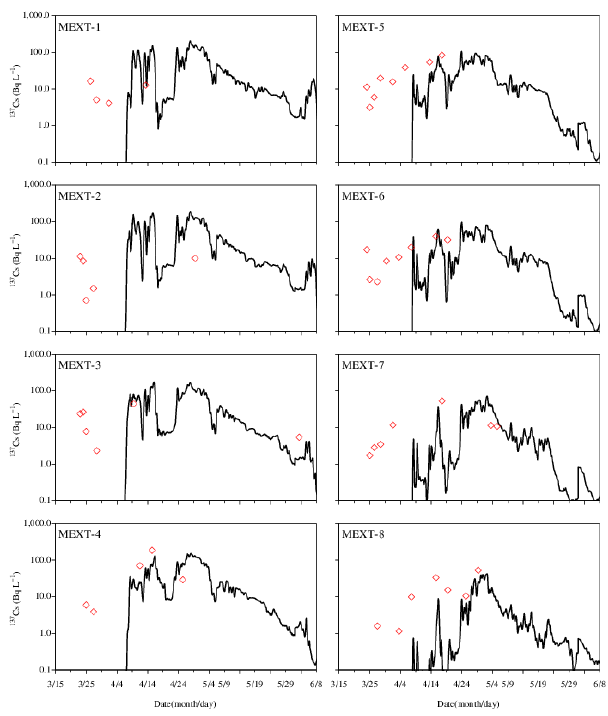
Fig. 7. Comparisons of model-computed and observed 137 Cs con- centrations at eight MEXT monitoring sites (30km off the coast) for the period 1 April–8 June 2011.